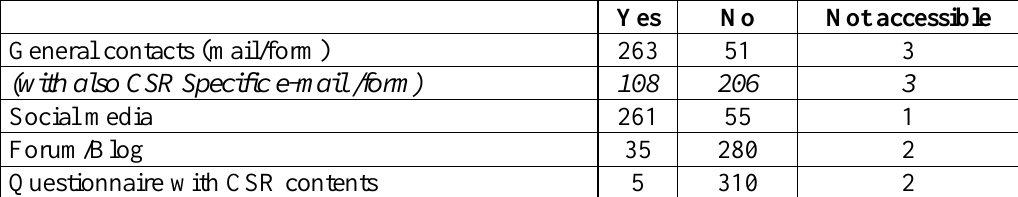
Table 4: Deliberative Published Communication Tools Used by DJSI Listed Companies